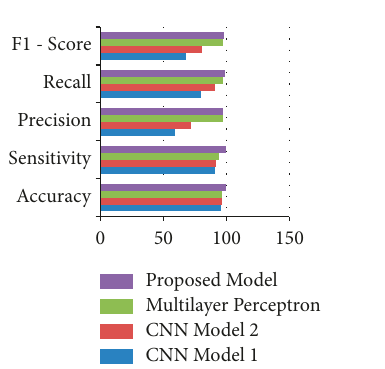
Figure 8: Graphical representation of the proposed